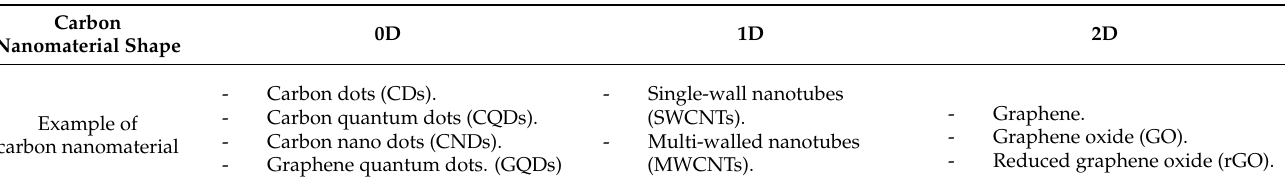
Figure 1. Classification of carbon nanomaterials: ( A ) 2D nanomaterials (e.g., graphene and graphene oxide); ( B ) 1D nanomaterials (single- and multi-walled nanotubes); and ( C ) 0D (carbon dots and graphene quantum dots). Table 1. Classification of carbon